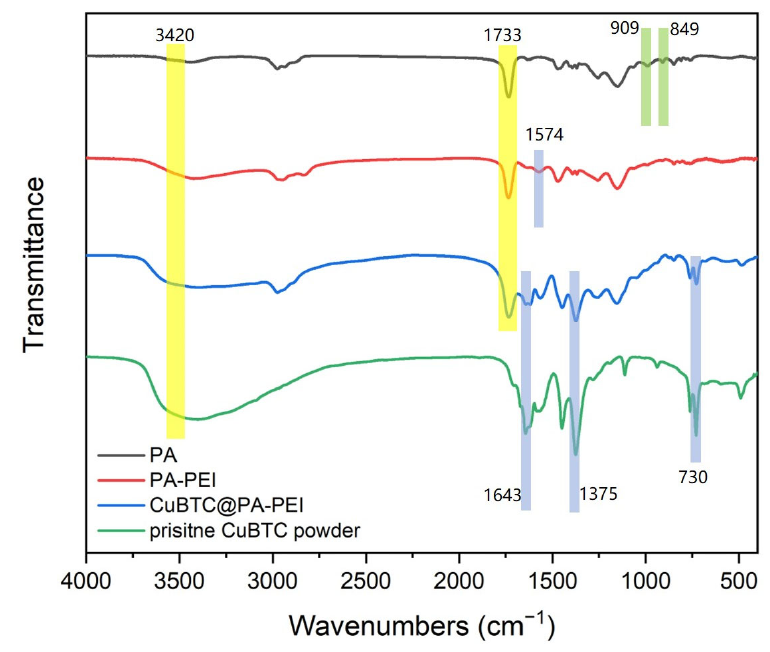
Figure 5. FTIR spectra of PA matrix, PA-PEI, CuBTC@PA-PEI, pristine CuBTC powder.